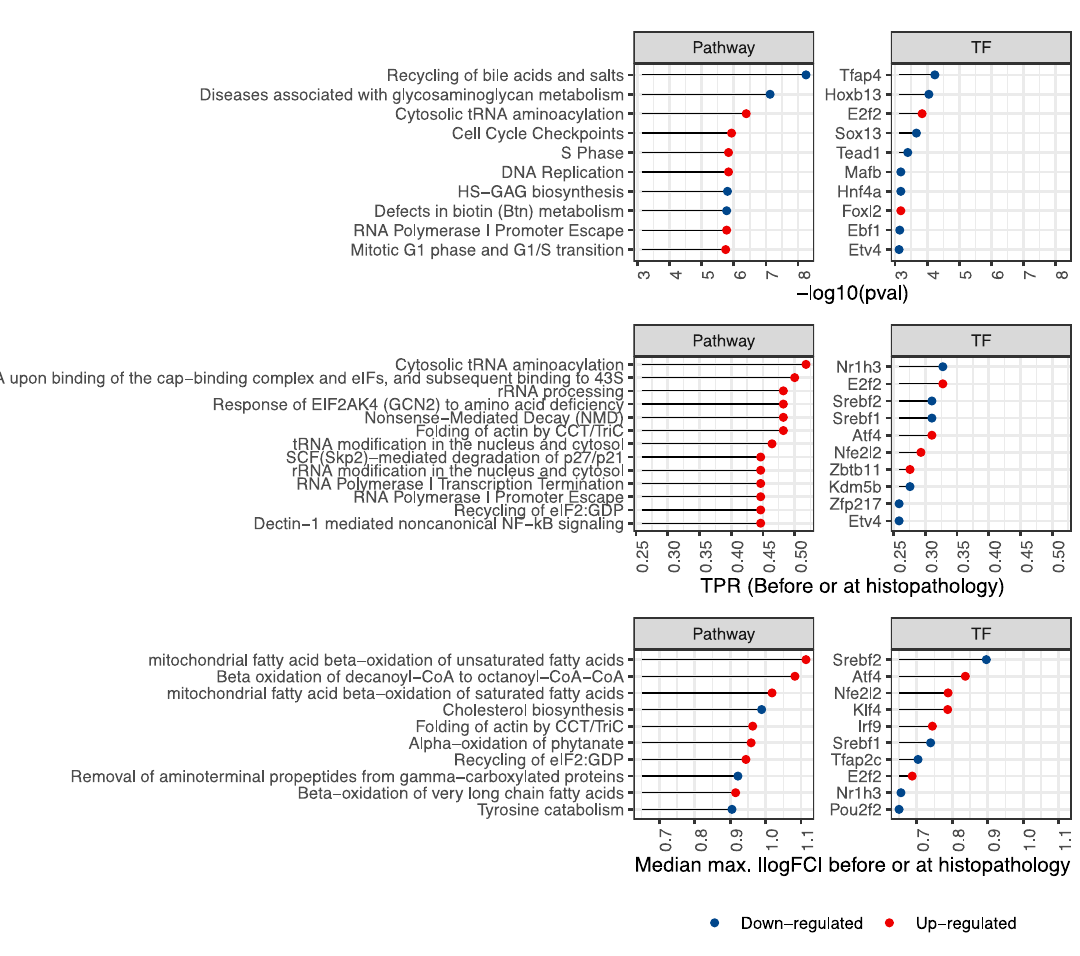
Fig 8. Highest ranking events by time concordance metrics. The ten transcription factor (TF)- and pathway-level events ranking highest by enrichment p- value, median max. |logFC| and true positive rate (TPR) before or at histopathology are shown. (EIF2a) including the upstream response mediated by eIF-2-alpha kinase GCN2 and the downstream role in protein translation mediated through interactions with tRNA. EIF2a is part of the same branch of Unfolded Protein Response (UPR) as Atf4 and causes its preferen- tial translation which, among others, mediates autophagy and proapoptotic response [43,52] and is a known predictor of DILI [44]. Furthermore, increased folding of actin by Chaperonin containing tailless complex polypeptide 1 (CCT) or tailless complex polypeptide 1 ring com- plex (TRiC) is found frequently and with large effect size. It has been previously linked to pro- teostasis and autophagy [53,54], but a role in DILI specifically is not yet known. As most strongly dysregulated events, metabolic pathways are found pointing to increased beta oxida- tion of fatty acids, as well as decreased cholesterol biosynthesis and tyrosine catabolism. Also the most strongly down-regulated TFs point towards lipid metabolism, i.e. the Sterol Regula- tory Element Binding Transcription Factor 1, Srebf1, and the Sterol Regulatory Element Bind-